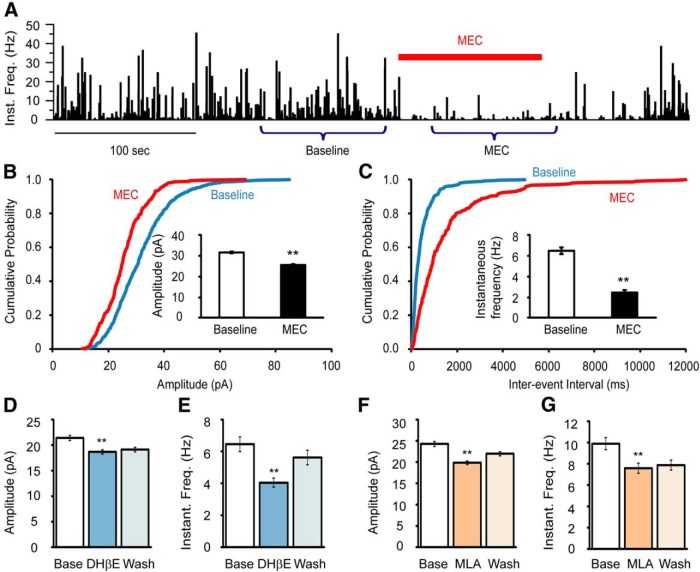
Nicotinic AChR antagonists suppressed glutamatergic mEPSCs onto Hcrt+ neurons. A, Mecamylamine, a nonselective nAChR antagonist, strongly suppressed mEPSCs onto Hcrt+ neurons. The bar above the graph indicates the duration of MEC (10 µM) exposure. Miniature EPSCs from two periods of time (Baseline and MEC) were used for analysis. B, Cumulative probability plot of the mEPSC amplitude at baseline and during MEC exposure was made from the recordings of four cells. Inset shows the mean values of the mEPSC amplitude at baseline and following MEC exposure. **p < 0.01. C, Interevent intervals of mEPSCs at baseline and upon MEC application from four cells (same cells as in C). Inset shows the mean instantaneous frequency of the mEPSCs at baseline and following MEC exposure. D, E, DHβE, an antagonist of heteromeric nAChRs (particularly α4β2 nAChRs), moderately suppressed the amplitude (D) and instantaneous frequency (E) of mEPSCs onto Hcrt+ neurons. n = 7 cells. F, G, MLA, a relatively selective α7 nAChR antagonist, partially suppressed mEPSC amplitude (F) and instantaneous frequency (G). n = 8 cells.